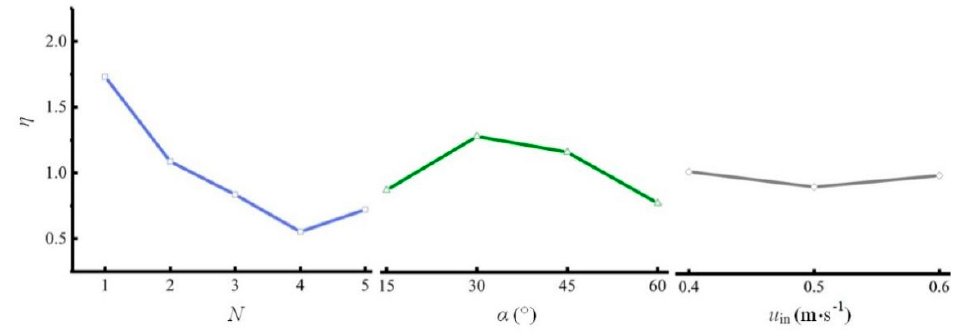
Figure 6. Relationships between the efficiency of the L/D cycle enhancement and three factors (single-sided illumination).